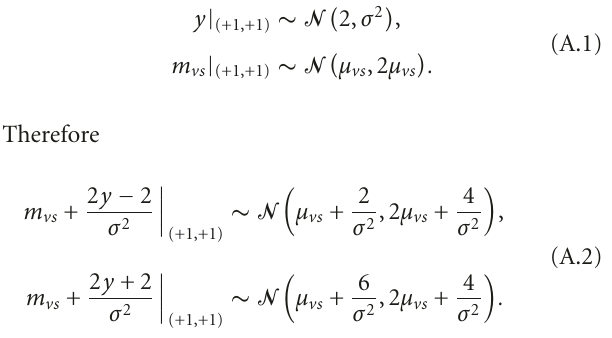
Table 2: Optimized LDPC codes for the 2-user Gaussian channel obtained with the erasure channel approximation of the state-check node. The distance between the ( E b /N 0 ) threshold δ (evaluated with true DE) and the Shannon limit S l is given in dBs. Rate